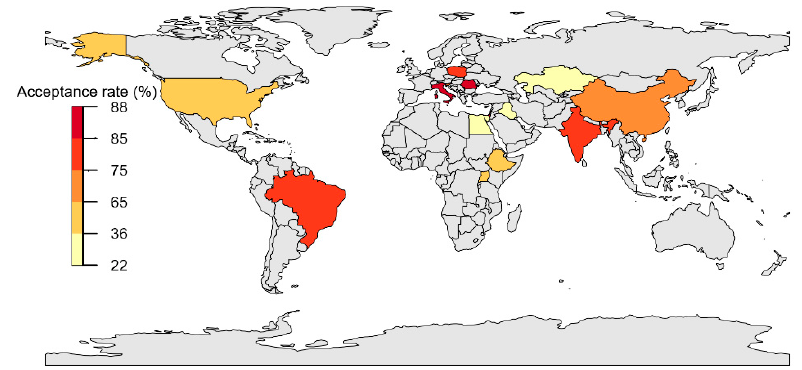
Figure 4. Map of COVID-19 vaccine acceptance rates among healthcare students by country.